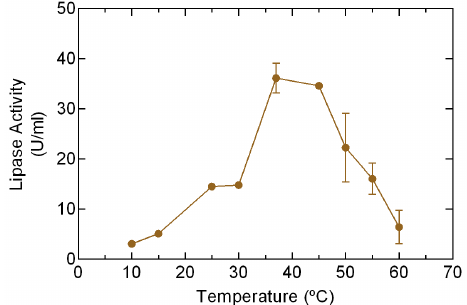
Figure 2. Evaluation of enzymatic activity in a crude extract. Lipolytic activity was measured spectrophotometrically at 96 h post induction of genes in the P. pastoris culture with methanol. The enzymatic activity was assayed with temperatures ranging from 10 to 60 °C. The errors bars represent SD values for 3